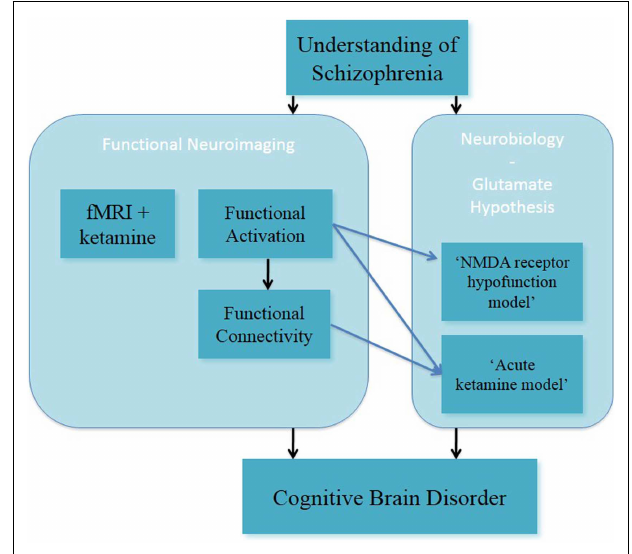
FIGURE 2 | Understanding of schizophrenia as a cognitive brain disorder – spatial “N-back” task